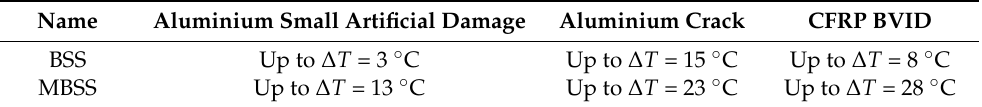
Table 5. Summary of result indicating the largest temperature change for which the damage could be accurately localized by applying temperature correction